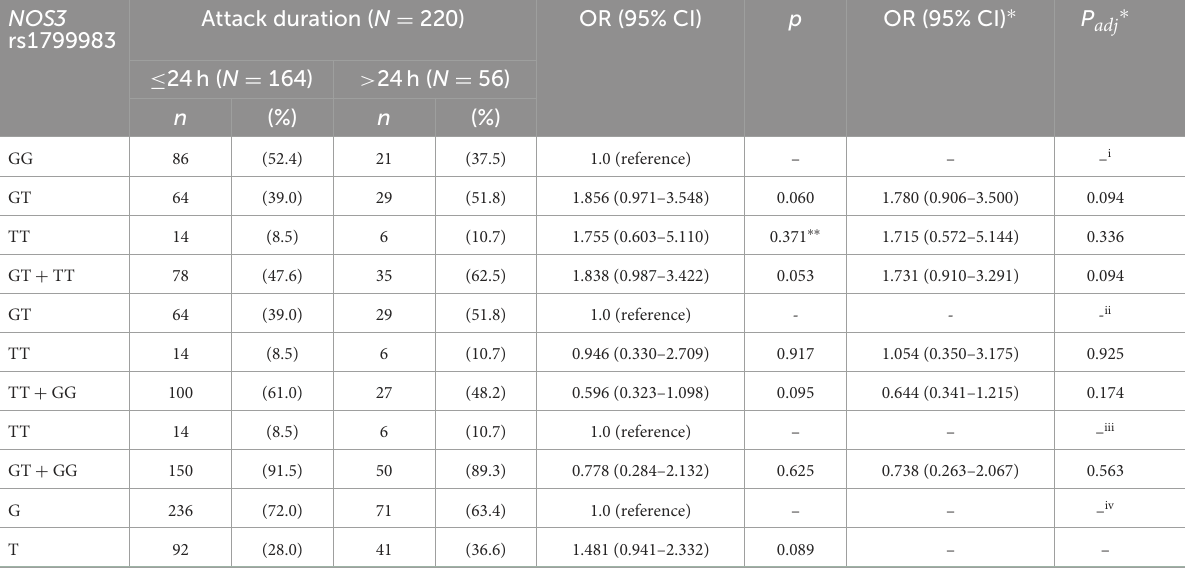
TABLE 7 Genotypic and allelic frequency distribution analysis of the NOS3 rs1799983 variant in migraineurs according to the typical duration of migraine attacks ( ≤ 24 vs. > 24h). NOS3